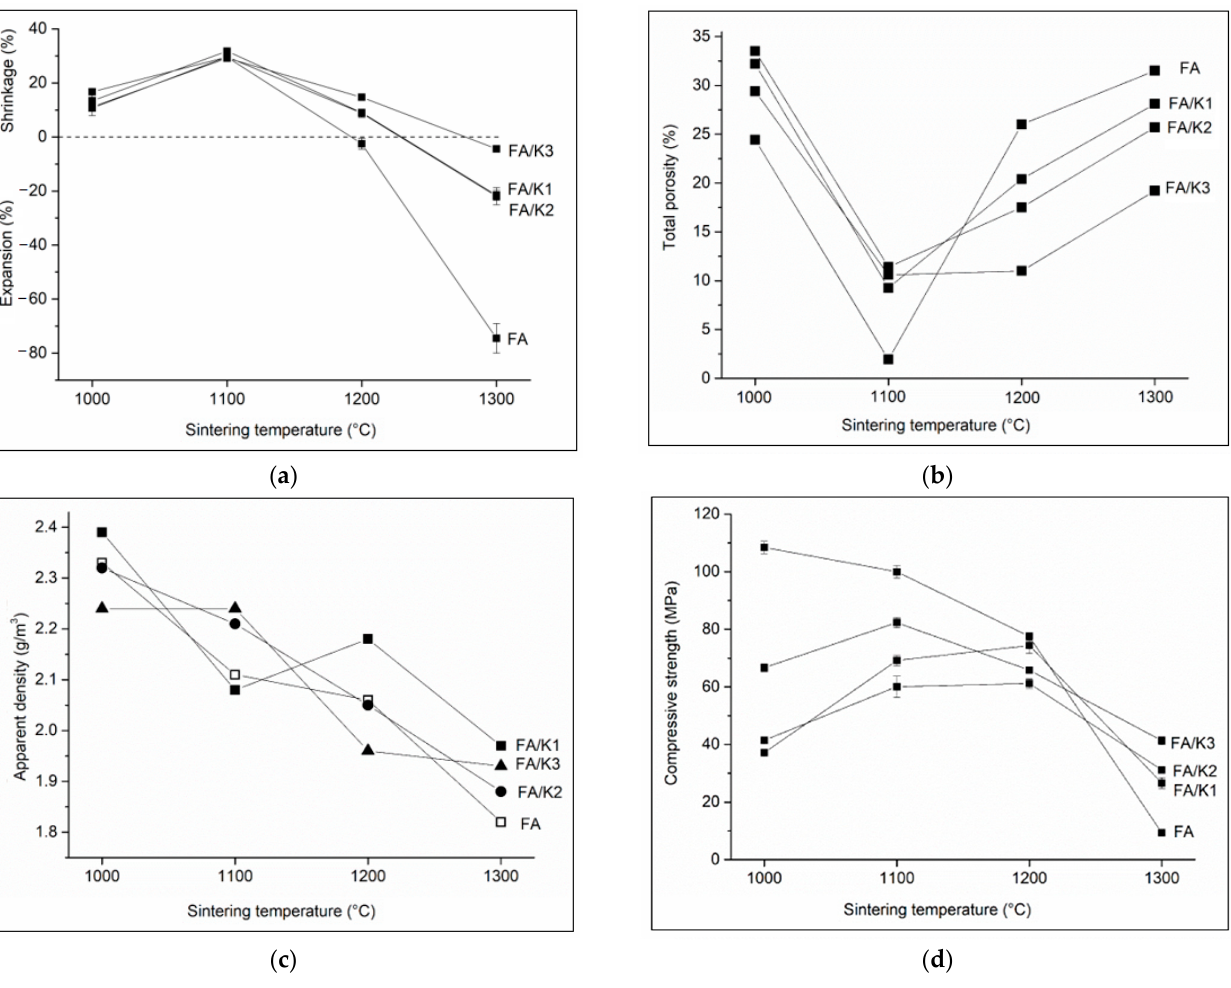
Figure 7. Post-sintering properties of ceramic samples FA and FA/K: ( a ) basal shrinkage, ( b ) porosity, ( c ) apparent density and ( d ) compressive strength.